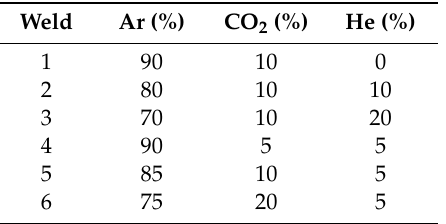
Table 2. Design of the shielding gas compositions.